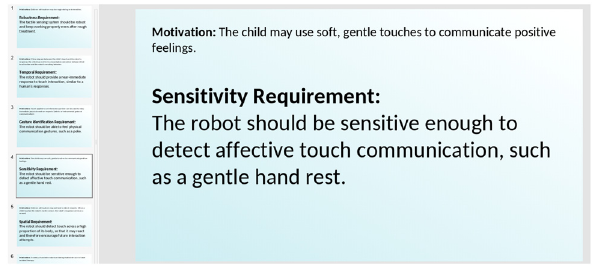
Figure 2: The requirement – ranking interface enabled participants to prioritize tactile - sensing requirements for the robot as they pre - ferred. Participants could reorder the six provided requirements by clicking on and dragging the respective slides in the navigation pane on the left. The main view enabled the participant to clearly see the individual requirements and the motivations that inspired them.